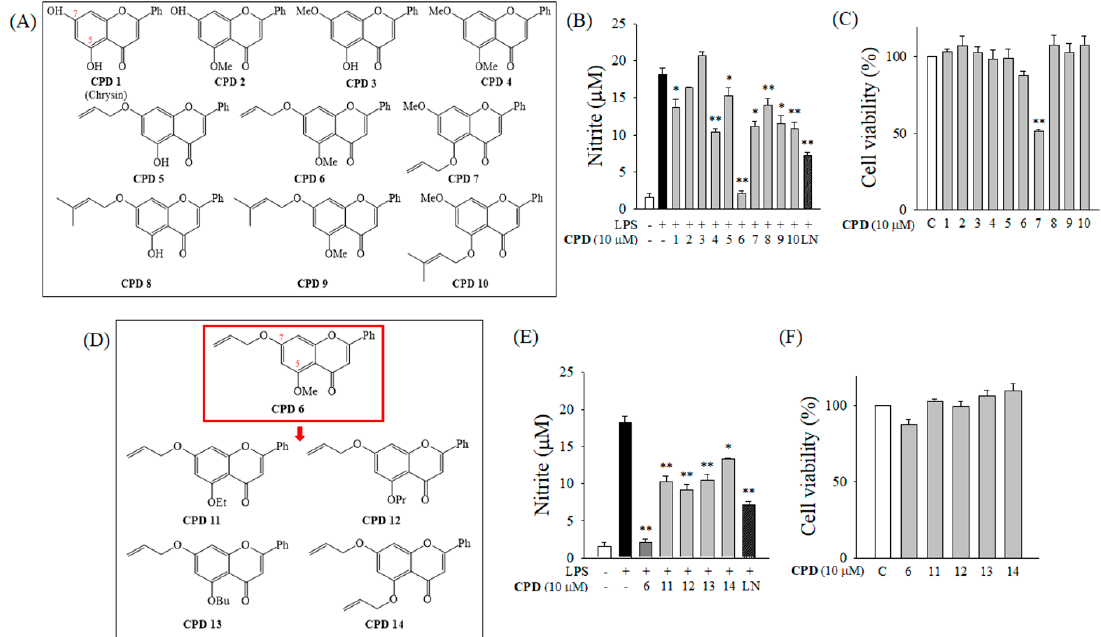
Figure 1. Inhibition of the release of nitric oxide (NO) in lipopolysaccharide (LPS)-activated macrophages by chrysin and its derivatives. ( A ) Chemical structures of chrysin (CPD 1) and its derivatives (CPD 2 to CPD 10) are shown. ( B ) Effect of chrysin and its derivatives on the release of NO was determined by Griess reaction after LPS challenge (200 ng/mL) for 24 h in murine macrophage RAW 264.7 cells. ( C ) Effect of chrysin and its derivatives (CPD 1 to 10) on cell viability was analyzed by an MTT assay after 24 h incubation in RAW 264.7 cells. ( D ) Four additional compounds (CPD 11 to 14), which are derivatives of CPD 6 (Red Box) at atom C (5). ( E and F ) Effect of CPD 6 and CPD 11 to 14 on NO accumulation ( E ) or cell viability ( F ) was examined. LN, L-NAME. Data are expressed as mean ± SEM, * p < 0.05, ** p < 0.01 vs. LPS-treated group. N = 3.